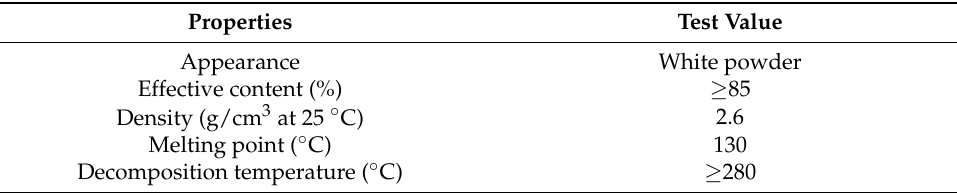
Table 3. Characteristics of the flame retardant.